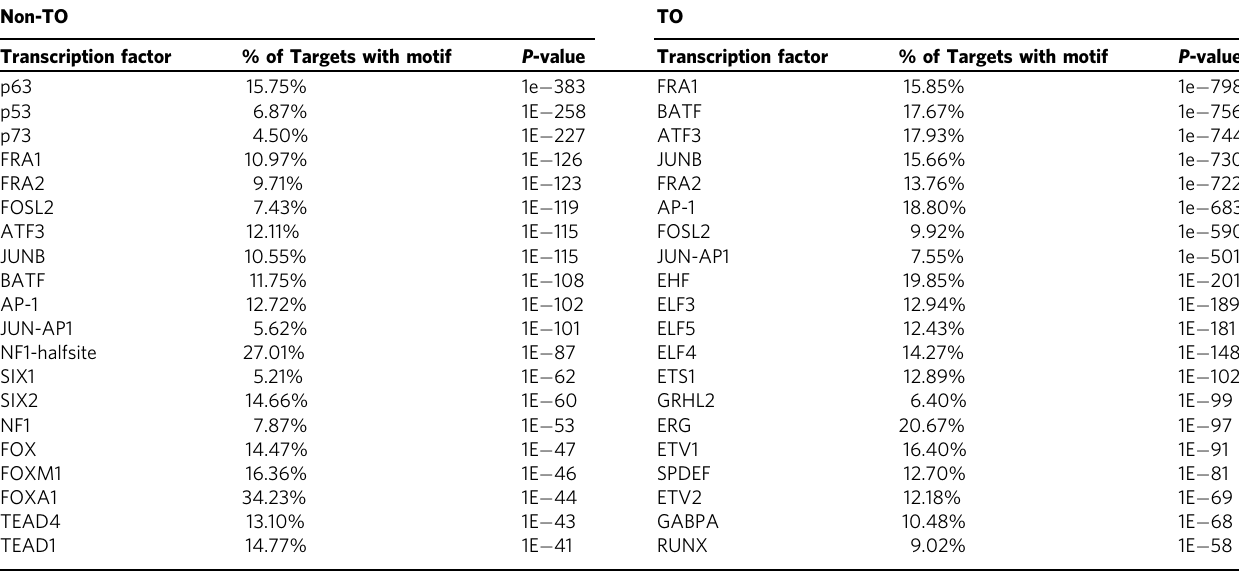
Table 2 Top 20 most enriched TF motifs in Non-TO and TO-derived basal cells. Non-TO